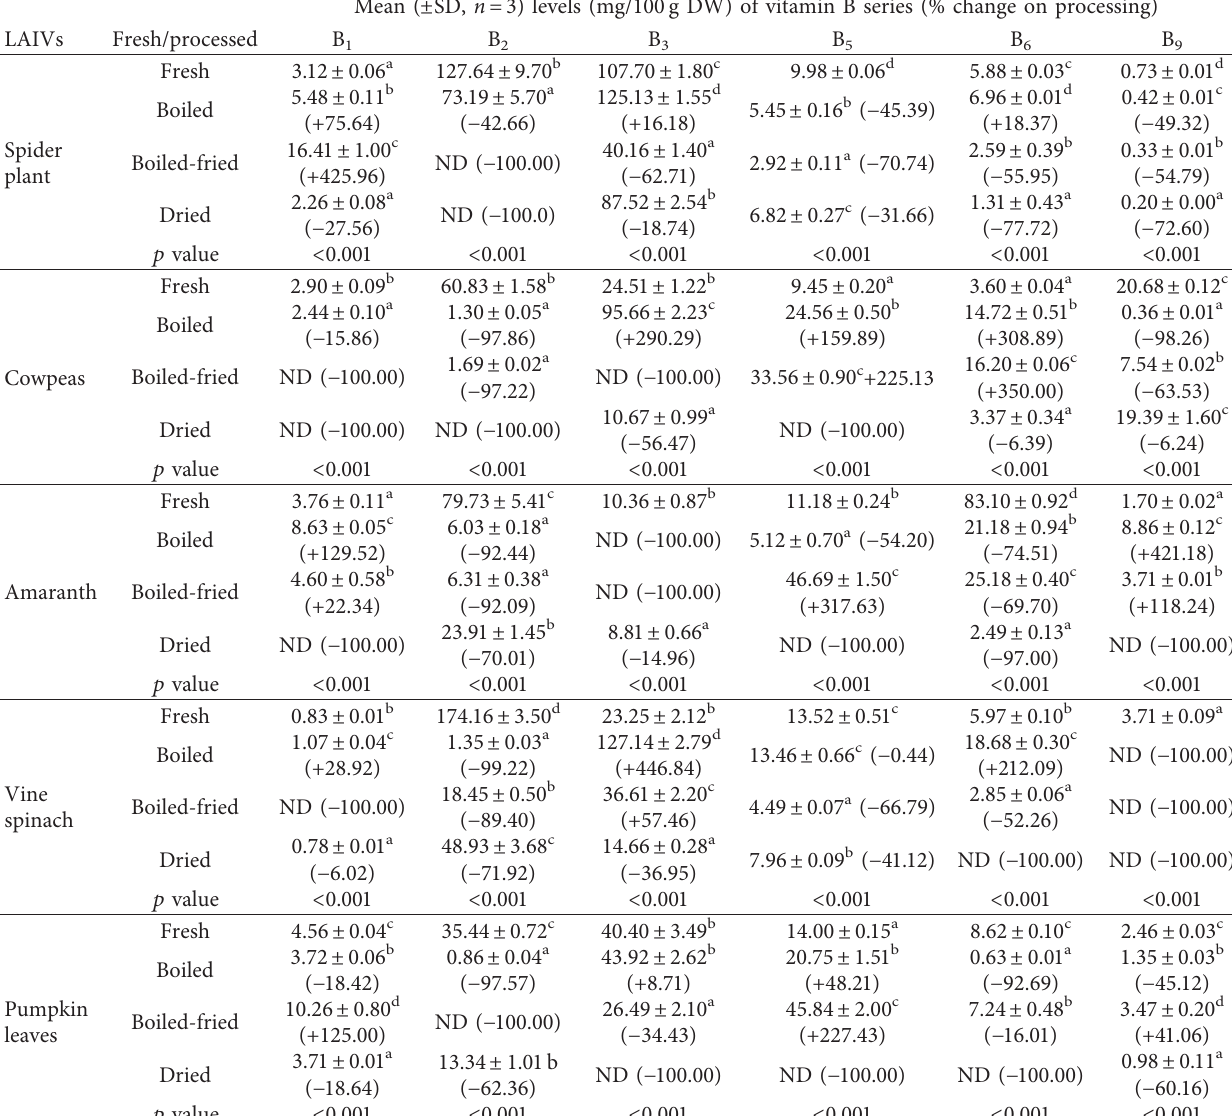
Table 2: Mean levels of vitamin B series and the percent change in fresh and processed